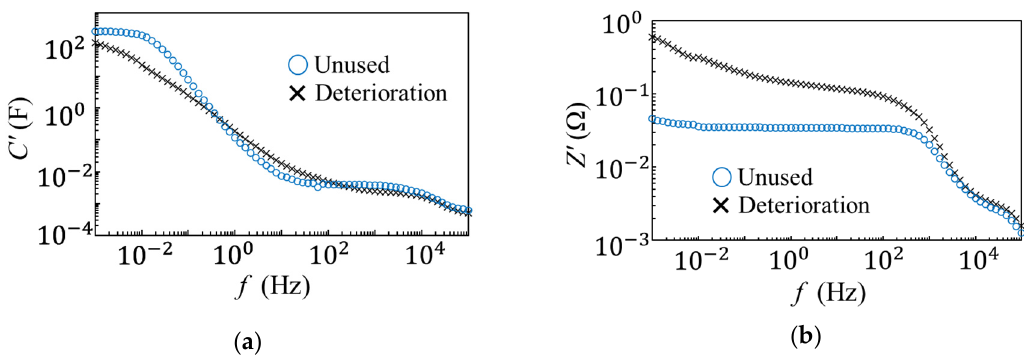
Figure 3. Capacitance and impedance measurements of the unused and degraded EDLCs. ( a ) Capacitance measurements and ( b ) impedance measurements.